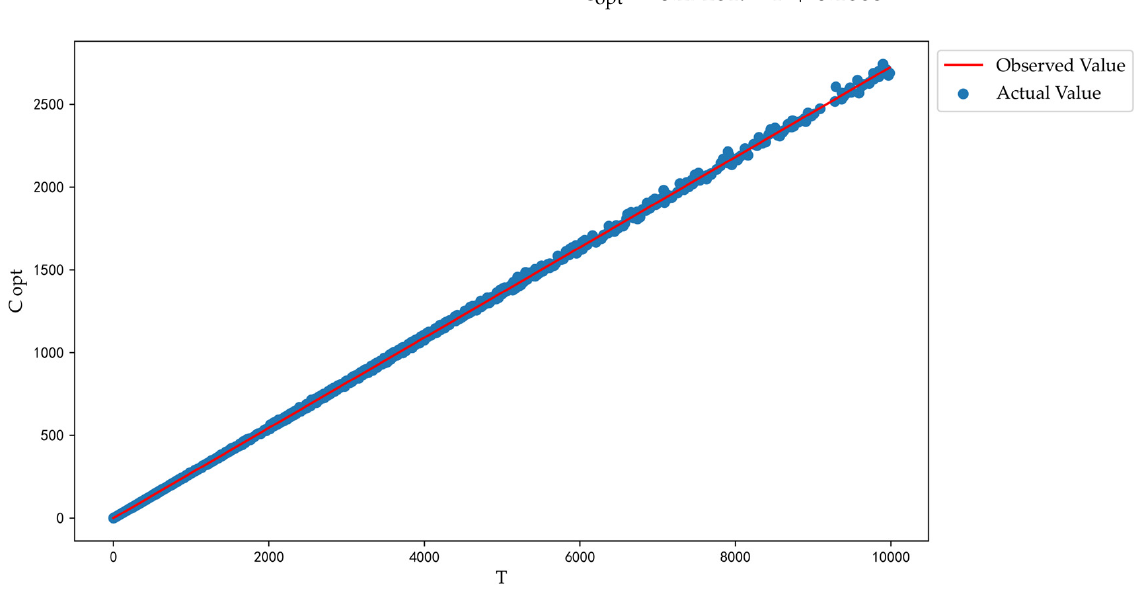
Figure 5. Schematic diagram of linear model.